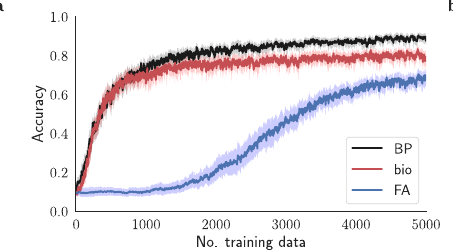
method and the corresponding backpropagated signal e BP ‘ (in degrees) for differ- ent layers ℓ =1, 2, 3, and 4. For both approaches, e 5 is computed using ∂ L = ∂ z L